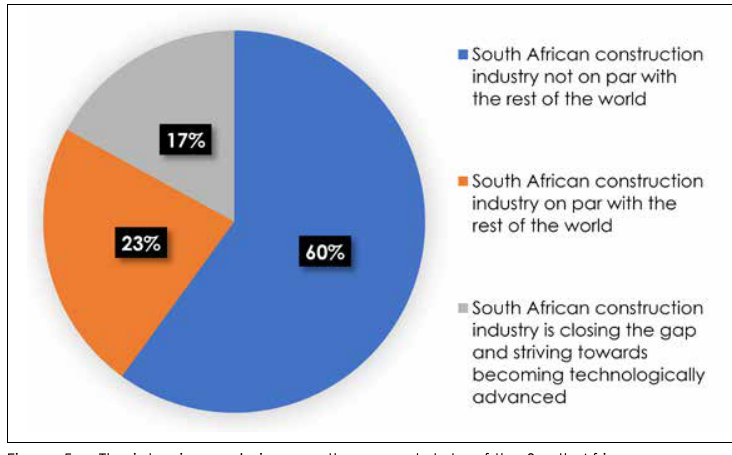
Figure 5: The interviewees’ views on the current state of the South African construction industry The suppliers who were using QR Codes were asked if they measured the impact of QR codes. The following responses were provided: No, as we just started using QR